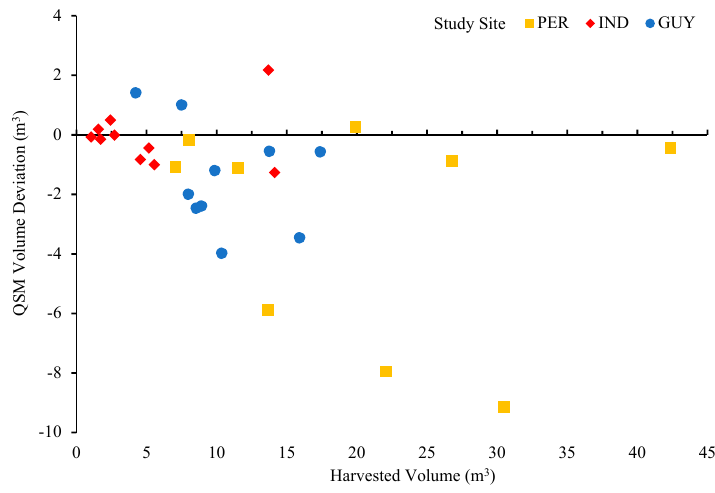
Figure 13. Volume deviation for each sample.